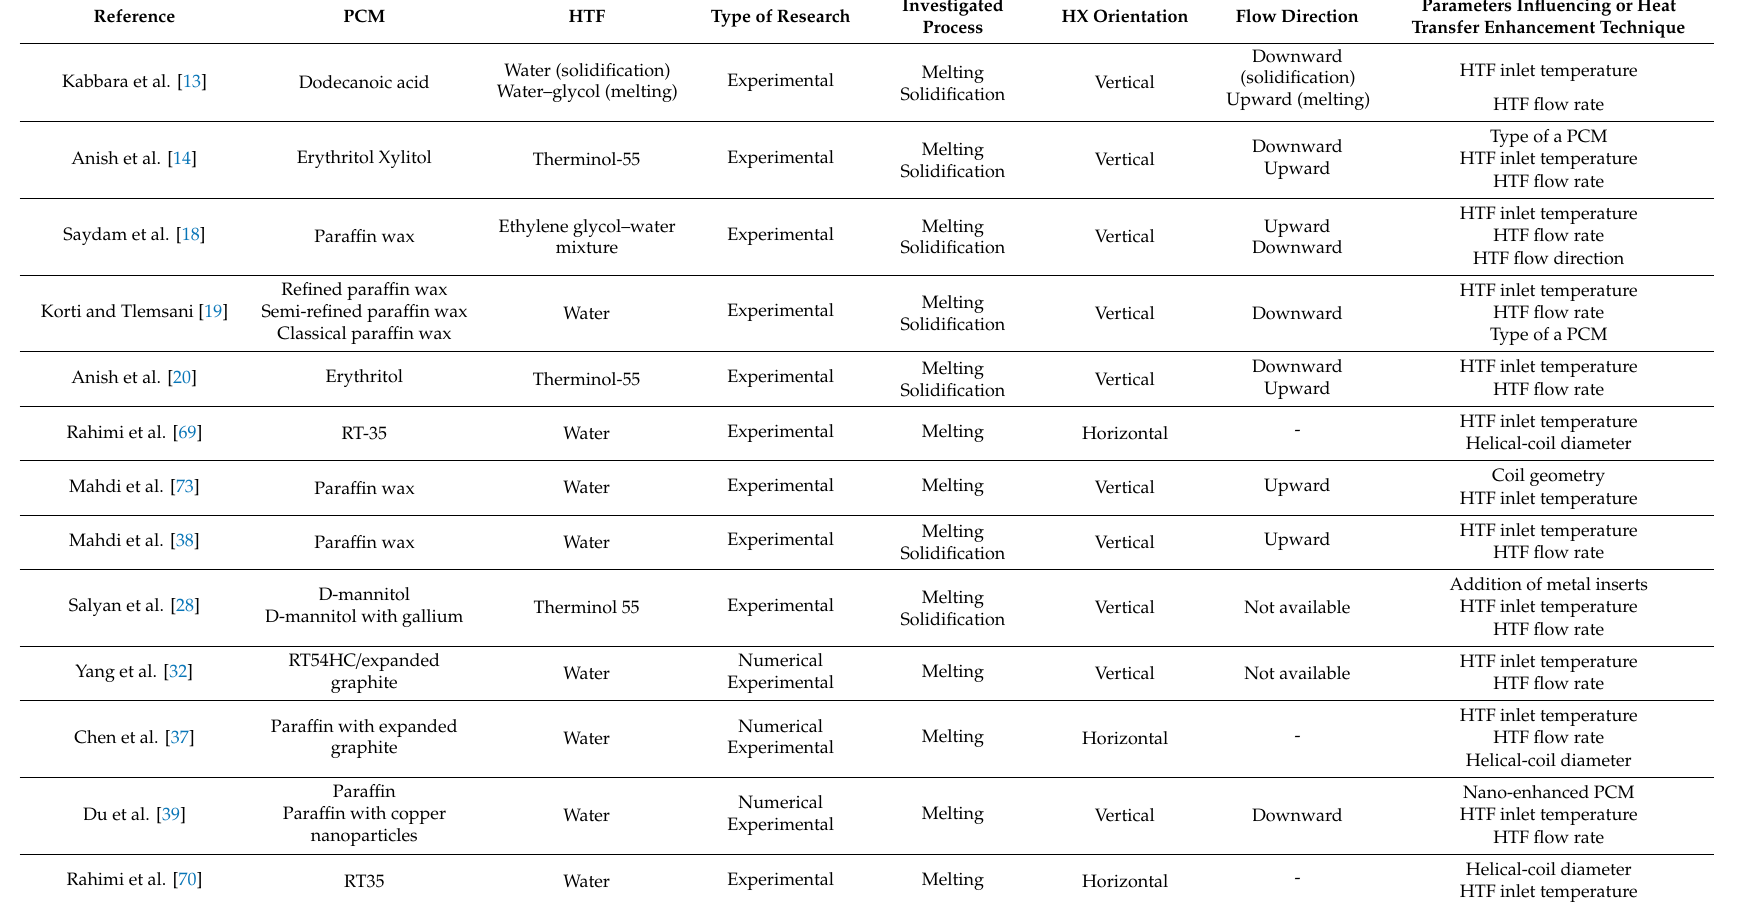
Table 3. Research on the helical-coil heat